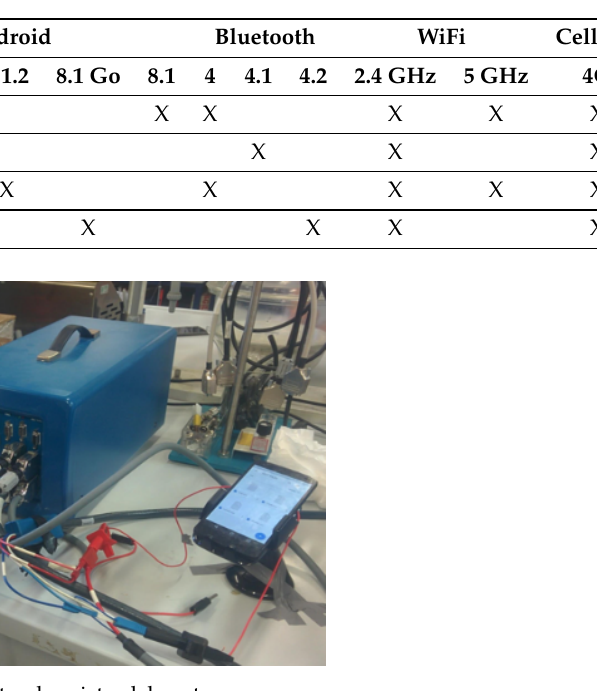
Table 1. Characteristics of the smartphones that have been used in our experiments.